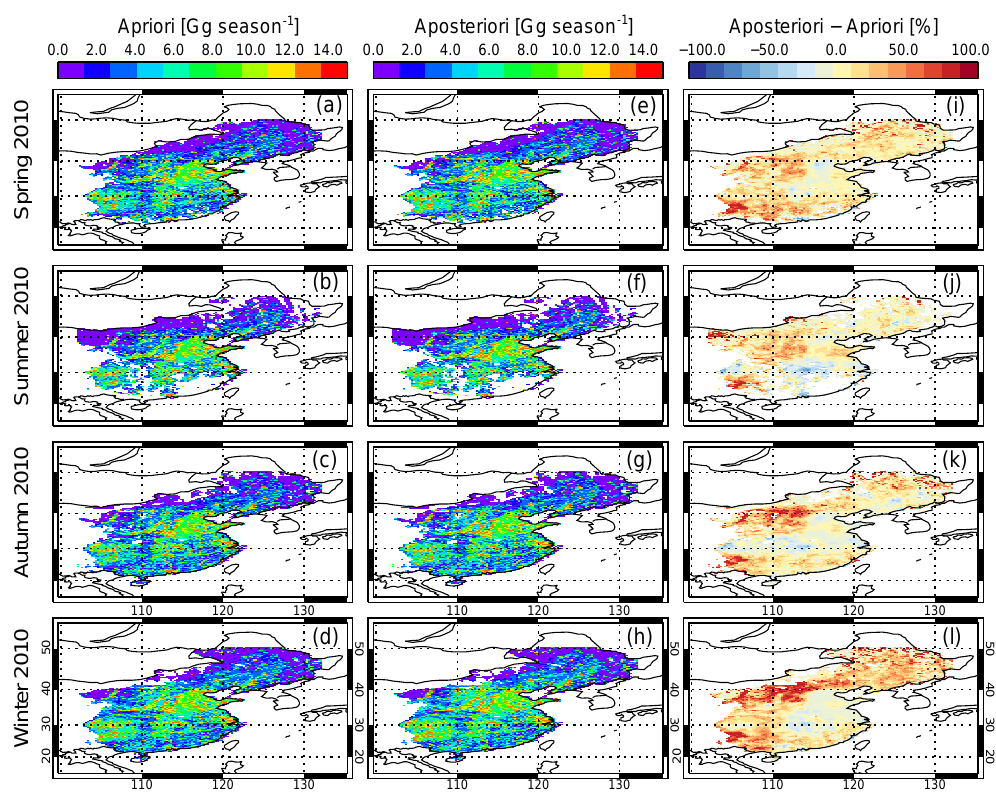
Figure 5. The seasonal variability of the a posteriori emissions calculated in this work (e–h) in gigagrams per season compared to the a priori MEIC v1.2 emissions (a–d) in Gg season − 1 as well as their percentage differences (i–l) in percent. From top to bottom; spring, summer, autumn and winter of reference year